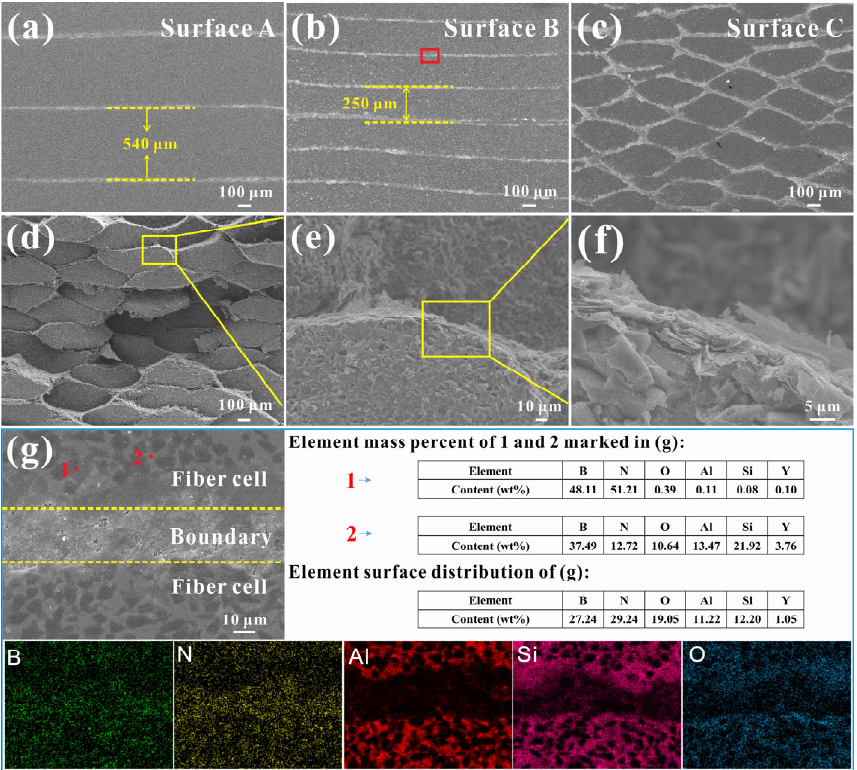
Fig. 3 (a–c) Microstructures and morphologies of different surfaces and (d–f) fracture surfaces obtained from mechanical tests of PcBN/hBN fibrous monolithic ceramics, together with (g) the enlarged morphology near cell boundary marked with red rectangle in (b) and its major element distribution